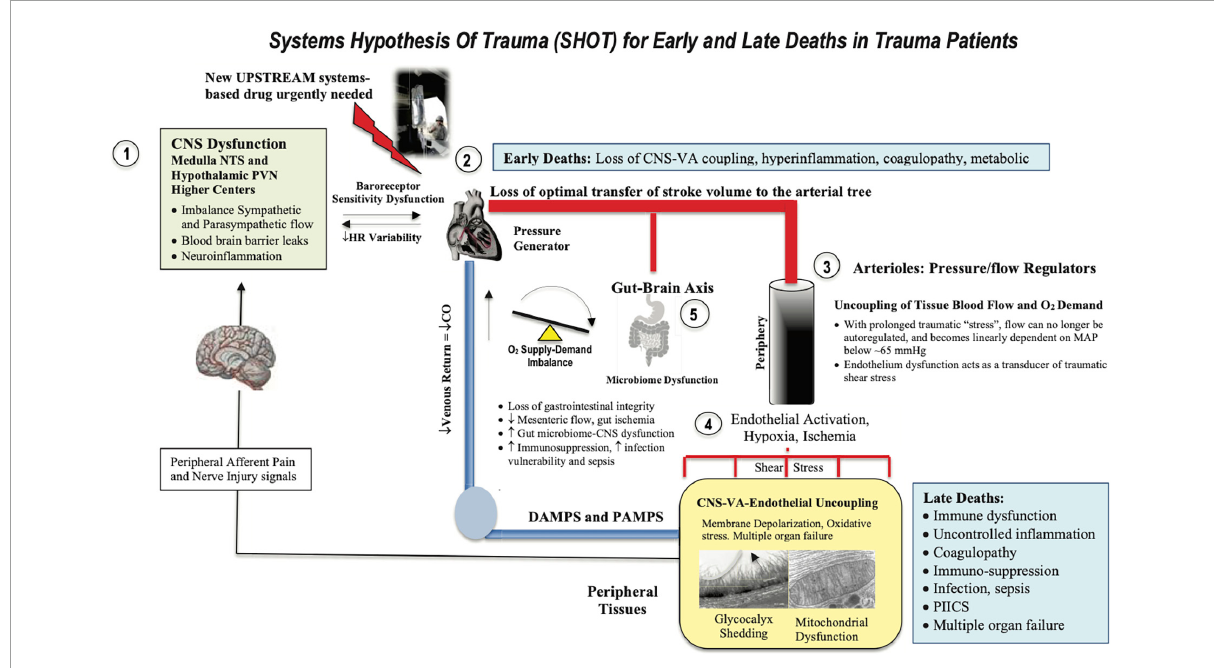
FIGURE3 Systems Hypothesis Of Trauma (SHOT) showing key inter-connected sites of uncoupling during early and late deaths: (1) brain, (2) heart, (3) vasculature, (4) endothelial-glycocalyx-mitochondrial unit, and (5) gut barrier breaches. Our hypothesis is that if central and local control of cardiac output and ventriculo-arterial (VA) coupling are improved, endothelial and microvascular function will be improved and tissue O 2 delivery will be maintained. An uncoupling is reflected by an increase in stress hormones, sympathetic discharge, loss of baroreceptor sensitivity, reduced heart rate variability (183, 184), unresolved inflammation, immune dysfunction, coagulopathy and mitochondrial dysfunction. New drugs are required to prevent inflammatory hyperdrive and support a VA-coupled, high flow, vasodilatory system with endothelial-glycocalyx protection and tissue oxygenation (185). HR, heart rate; ATP, adenosine triphosphate; CNS, central nervous system; NTS, nucleus tractus solitarius; PVN, paraventricular nucleus of the hypothalamus; MAP, mean arterial pressure. PIICS, Persistent Inflammation, Immunosuppression and Catabolism Syndrome, see text for description of early and late